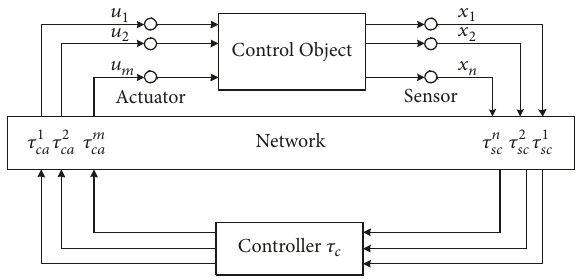
Figure 1: Data communication scheme of the networked control